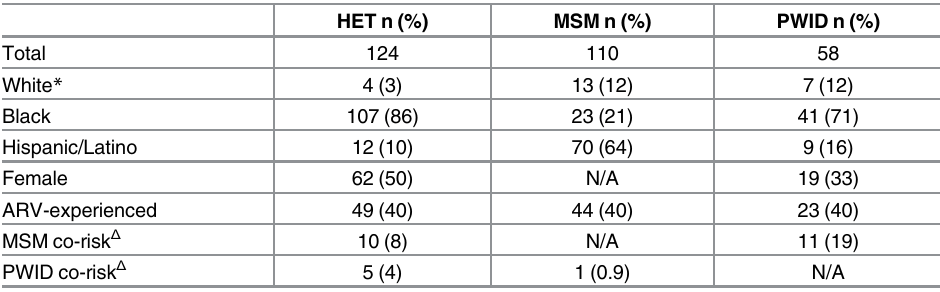
Table 1. HIV-positive participants with DBS available for testing. HET n (%) MSM n (%) PWID n (%) Total 124 110 58 White * 4 (3) 13 (12) 7 (12) Black 107 (86) 23 (21) 41 (71) Hispanic/Latino 12 (10) 70 (64) 9 (16) Female 62 (50) N/A 19 (33) ARV-experienced 49 (40) 44 (40) 23 (40) MSM co-risk Δ 10 (8) N/A 11 (19) PWID co-risk Δ 5 (4) 1 (0.9)